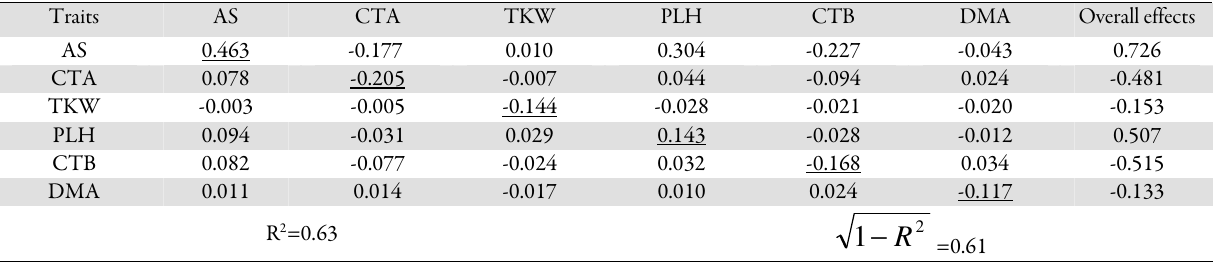
Tab. 3. Direct and indirect effects of first order predictor variables on grain yield of wheat varieties Traits